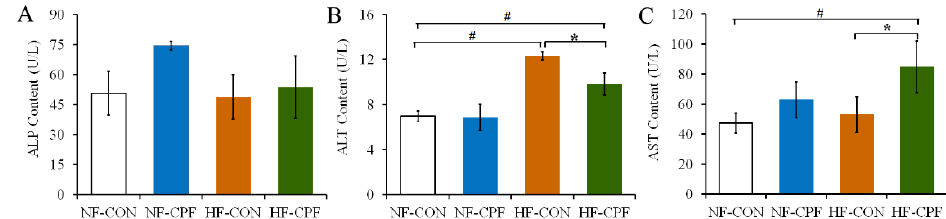
Figure 5. Effects of CPF on liver function of the rat under the NF diet and HF diet. ( A ) ALP content. ( B ) ALT content. ( C ) AST content. CPF—Chlorpyrifos. NF-CON—fed a normal-fat diet and vehicle. NF-CPF—fed a normal-fat diet and chlorpyrifos. HF-CON—fed a high-fat diet and vehicle. HF-CPF—fed a high-fat diet and chlorpyrifos. The symbol * and # indicates a significant difference be- tween the covered groups at p < 0.05.